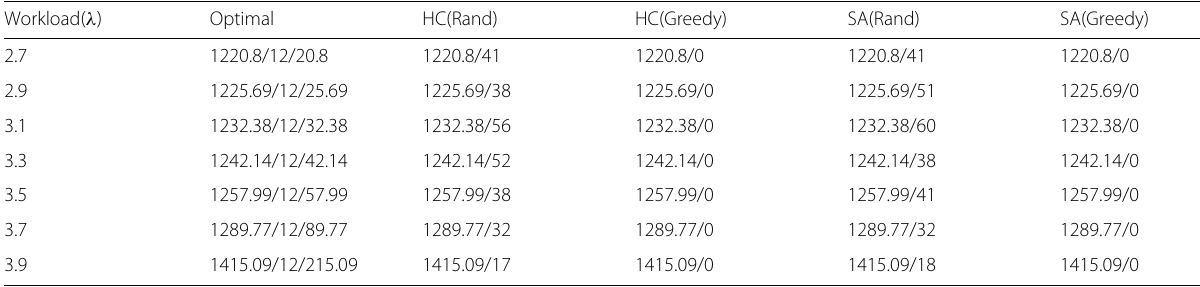
Table 4 Comparing HC(Rand), HC(Greedy), SA(Rand), SA(Greedy) with optimal solution Workload( λ